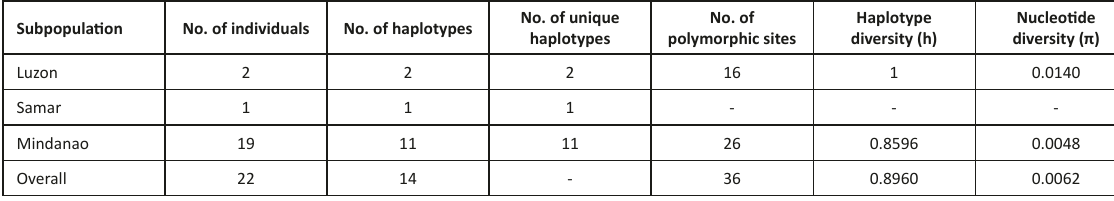
Table 2. Genetic diversity indices for each of the subpopulations of the Philippine Eagle.